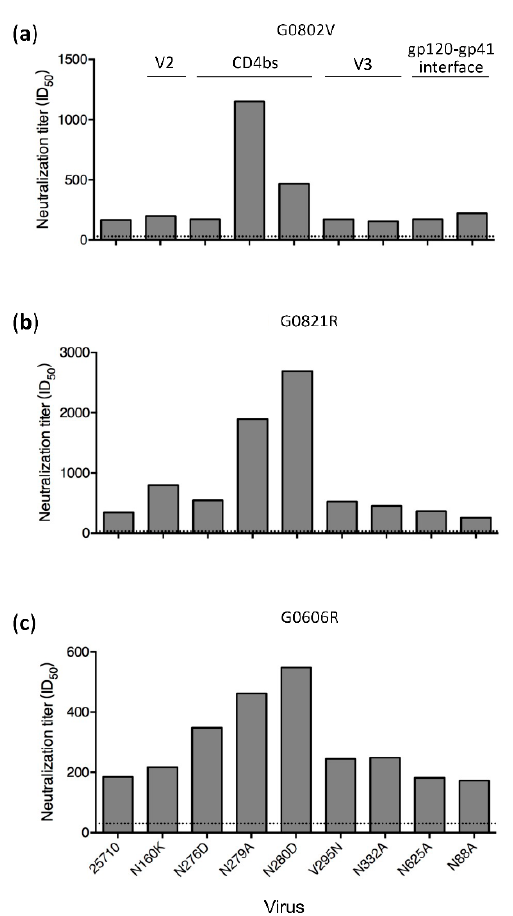
Figure 6. High levels of neutralization sensitivity of loop D mutants to plasma from macaques infected with other SHIV strains. Neutralization activities were determined for the plasma samples from macaques G0802V ( a ) and G0821R ( b ) which were infected with SHIV SF162P3 , and macaque G0606R ( c ) which was infected with SHIV CHN19P4 . The neutralization assay was performed using the 25710 env mutant set. The dotted line indicates the lowest dilution (1:30) for the neutralization assay.